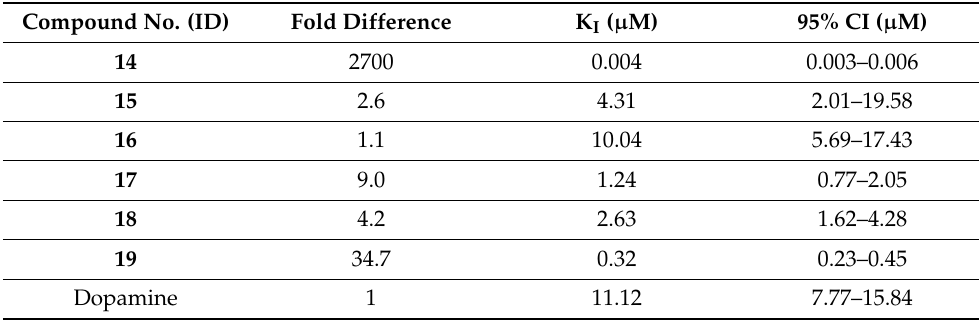
Table 4. Summary of the determined activities: K I values of the different compounds at D 2 R. Activities are also expressed as fold differences in comparison to the determined K I of dopamine. K I values in µM were determined using n = 6; 95% confidence intervals (CI) are shown. Dopamine is shown as the control.